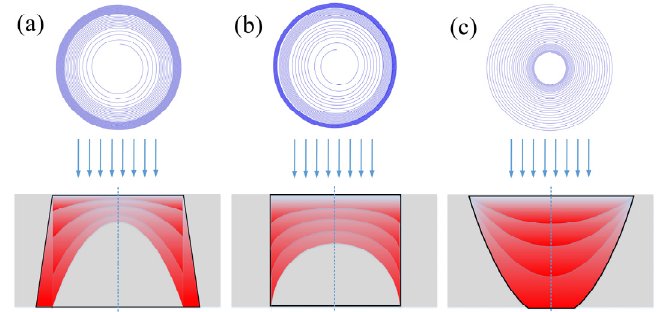
Figure 8. Microhole process with different tapers due to different scanning paths: ( a ) inverted cone; ( b ) straight cone; ( c ) normal cone.